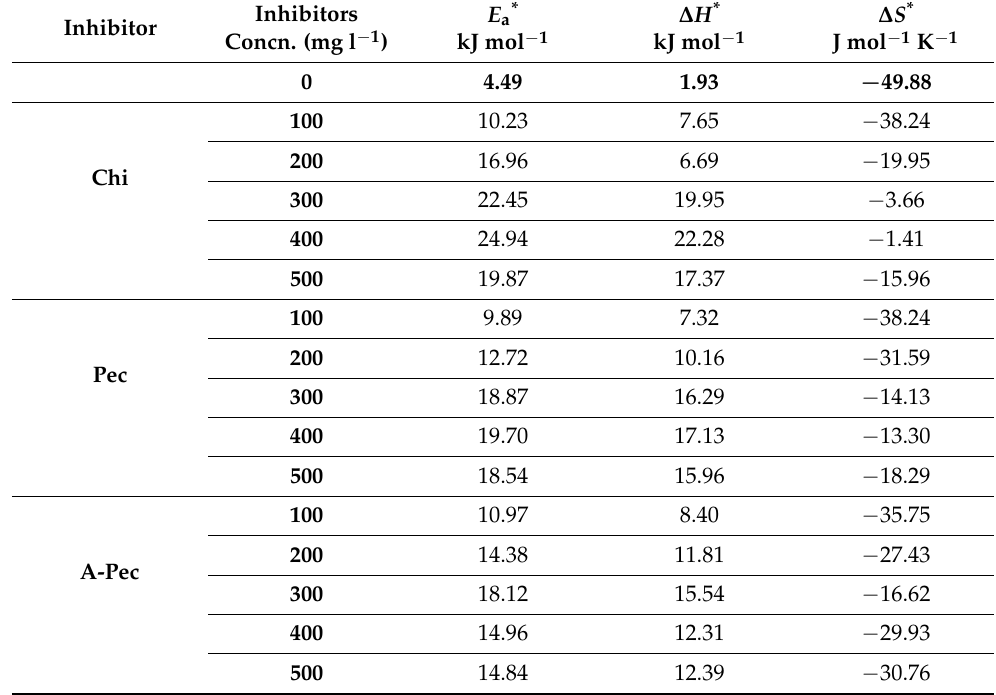
Table 6. Activation parameters for mild-steel corrosion in 0.5 M HCl solution in the absence and presence of the examined carbohydrate polymers.